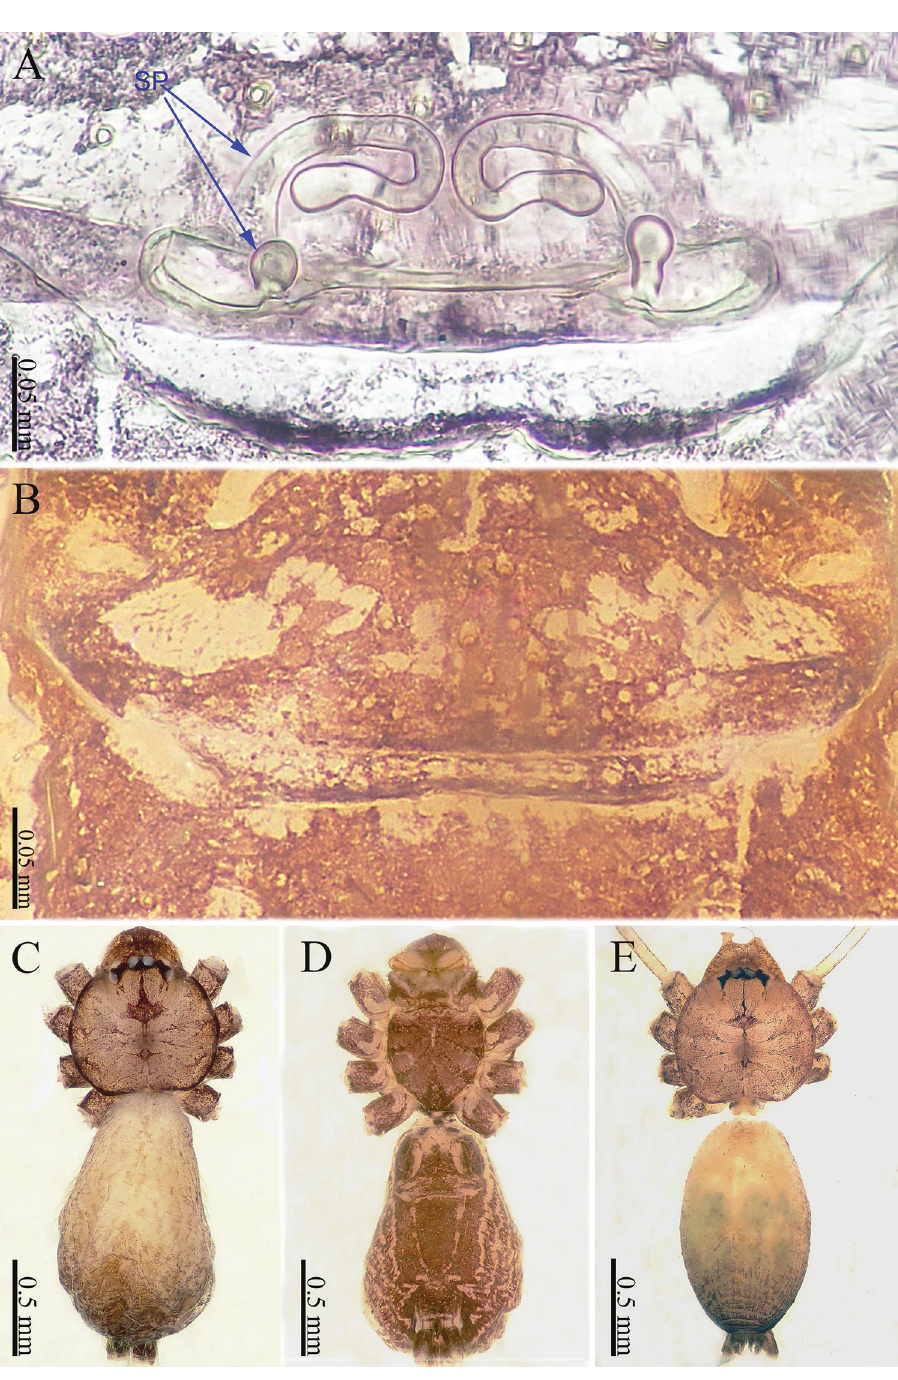
Figure 2. Sinoderces khanensis Li & Li, sp. nov., male holotype and female paratype A internal genitalia, dorsal view B female epigastric furrow, ventral view C female habitus, dorsal view D female habitus, ventral view E male habitus, dorsal view. Abbreviation: SP